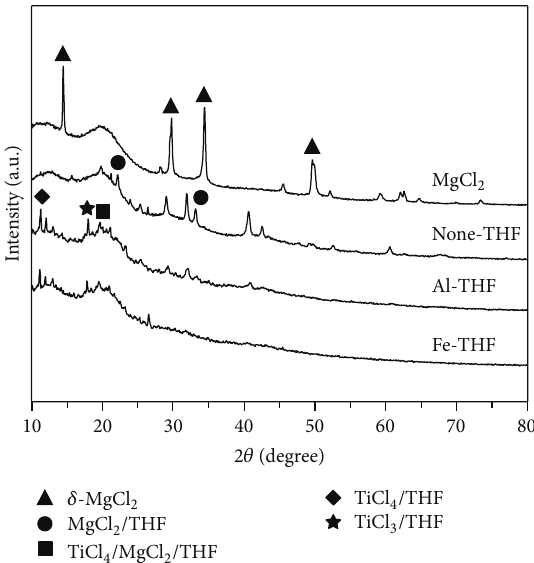
Figure 2: XRD patterns of prepared